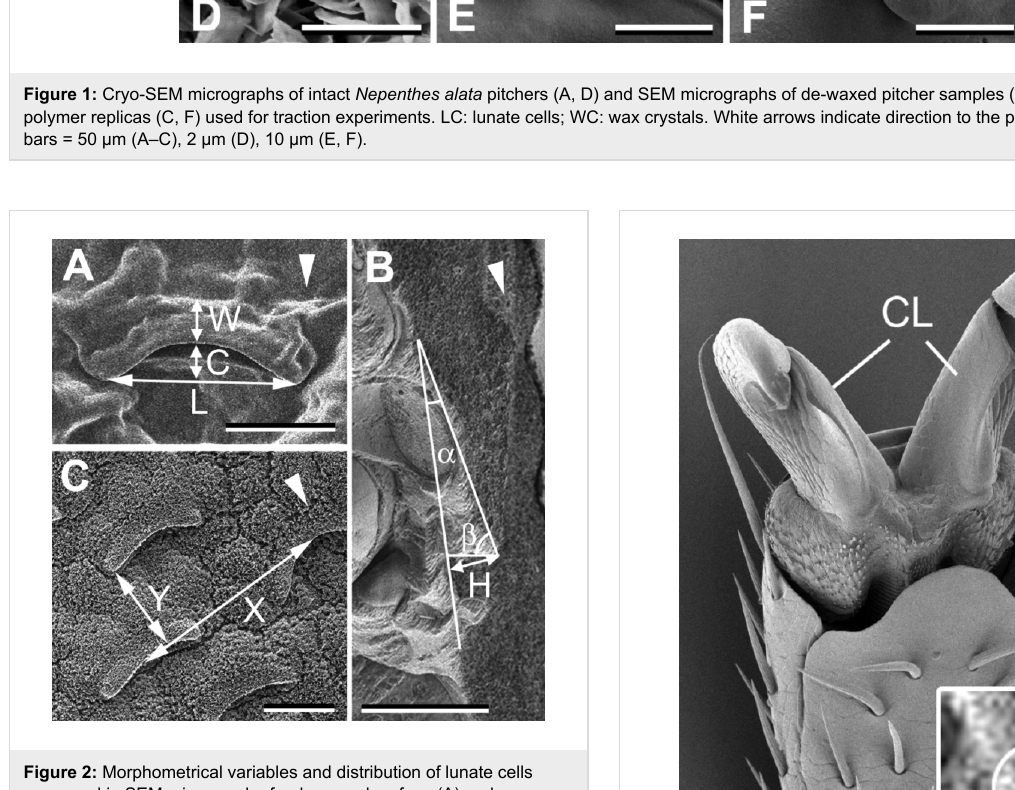
Figure 2: Morphometrical variables and distribution of lunate cells measured in SEM micrograph of a de-waxed surface (A) and cryo- SEM micrographs of an intact surface (B, C) of the slippery zone in Nepenthes alata pitchers: α = 19.53 ± 3.92°, β = 68.12 ± 17.01°, C = 6.95 ± 1.46 μ m, H = 9.41 ± 2.08 μ m, L = 35.51 ± 6.02 μ m, W = 7.21 ± 1.01 μ m, X = 84.90 ± 29.39 μ m, Y = 51.16 ± 16.05 μ m, N = 10–20. A, C: Top view of the surfaces. B: Fractured sample, used to measure variables α and β (angles between the exposed side of the lunate cell and its adjoining sides). White arrowheads indicate direc- tion to the pitcher bottom. Scale bars = 20 μ m. [B: courtesy of M. Benz